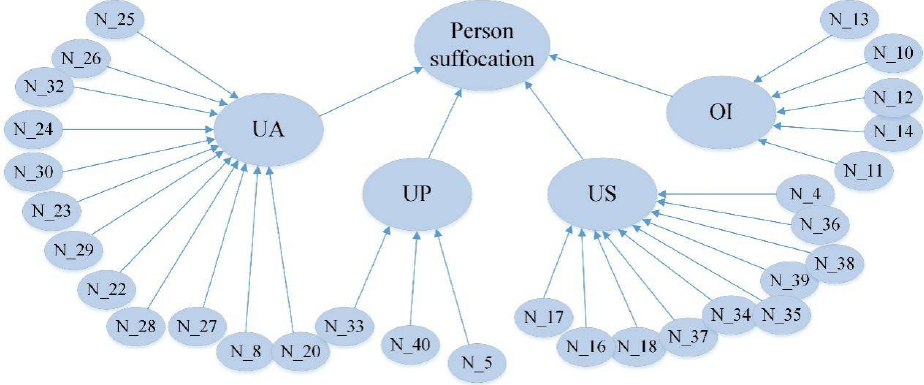
Figure 3. BN developed for the human-related factors analysis.